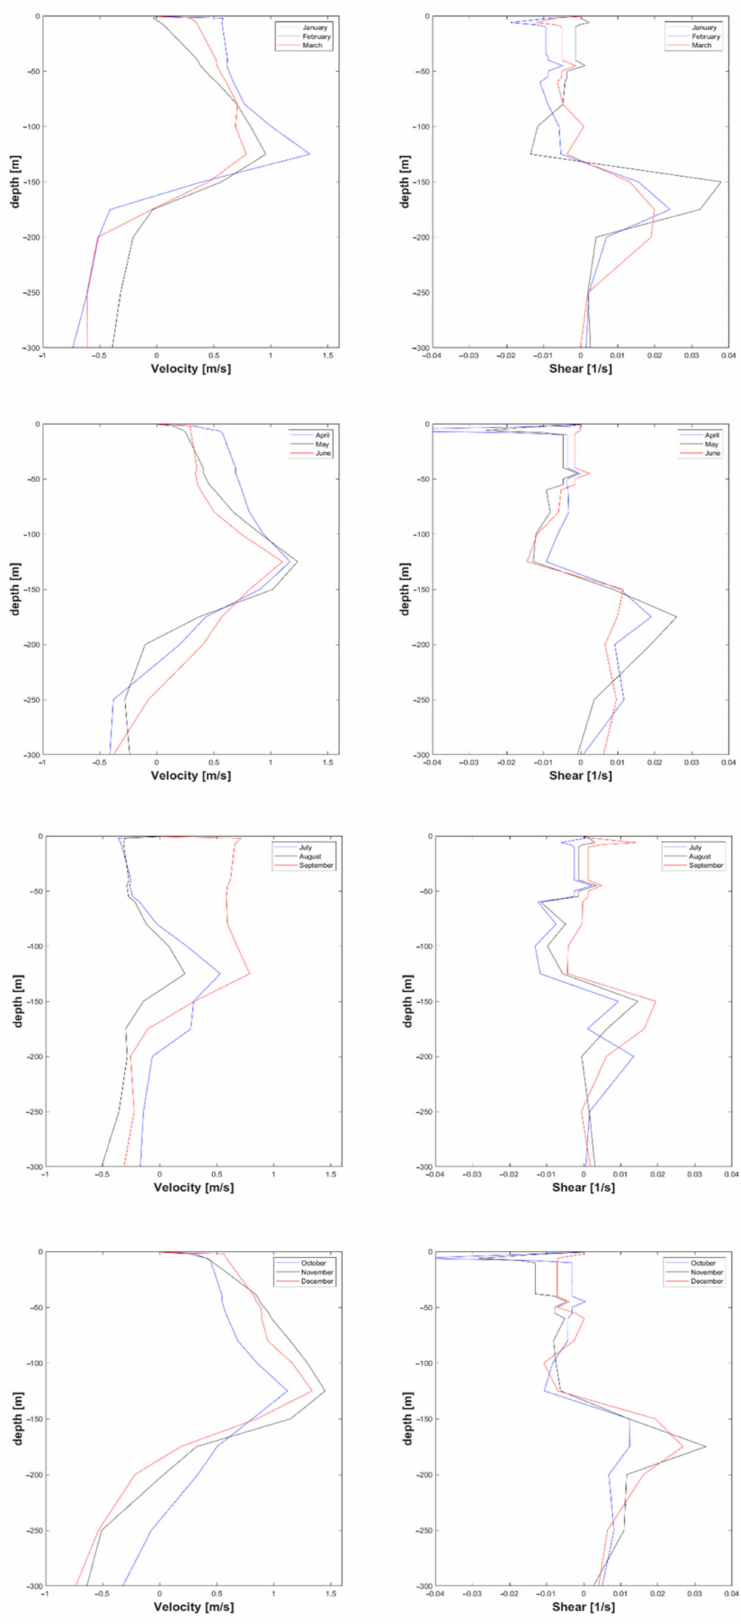
Figure 3. Vertical profiles of velocity (at the western output location in Figures 1 and 2) and shear associated to maximum events for each